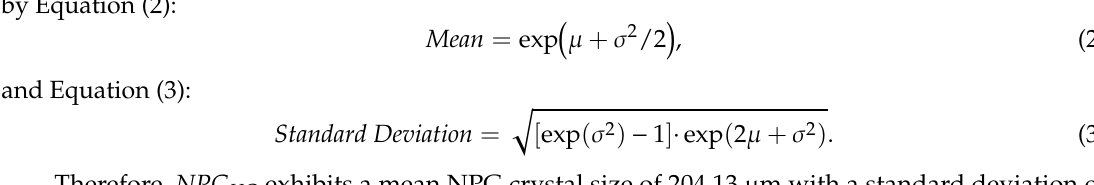
Figure 2. ( a ) NPG HG : Histogram and cumulative probabilities of NPG crystal size distribution; ( b ) NPG HG : lognormal probability plot of NPG crystal size; ( c ) NPG BM : Histogram and cumulative probabilities of NPG crystal size distribution; ( d ) NPG BM : Lognormal probability plot of NPG crystal size.